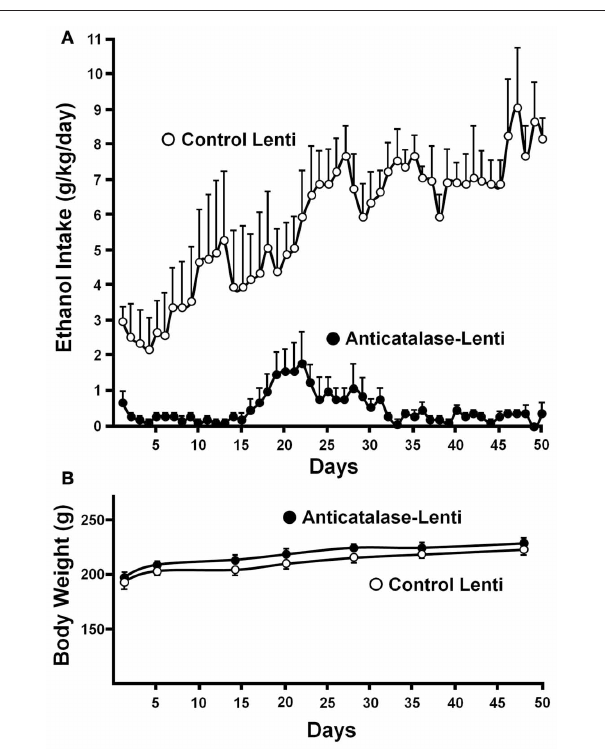
FIGURE 3 | Virtual long-lasting abolition of ethanol intake following the single administration of an anticatalase viral vector into the brain ventral tegmental area (VTA). (A) Ethanol drinker rats (UChB line) were microinjected into the VTA 1.0 microliter (8 × 10 4 particles) of a lentiviral vector coding for an shRNA against catalase mRNA. Controls received the empty lentiviral vector. Four days after the vector injection animals had 24-h access to 10% ethanol and water. (B) Animal weight was not affected by the anticatalase vector. Water intake (not shown) was not modified either (from Karahanian et al., 2011). Replicate studies by Quintanilla et al. (2012) showed that the anticatalase lentiviral vector reduced VTA catalase activity by 70–80%.